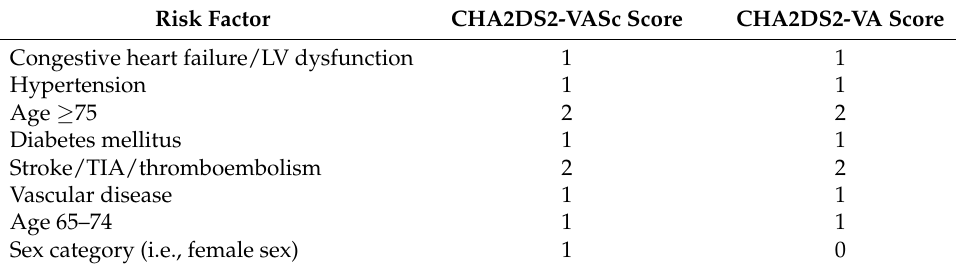
Table 1. Risk factors included in the CHA2DS2-VASc score and CHA2DS-VA score. Risk Factor CHA2DS2-VASc Score CHA2DS2-VA Score Congestive heart failure/LV dysfunction 1 1